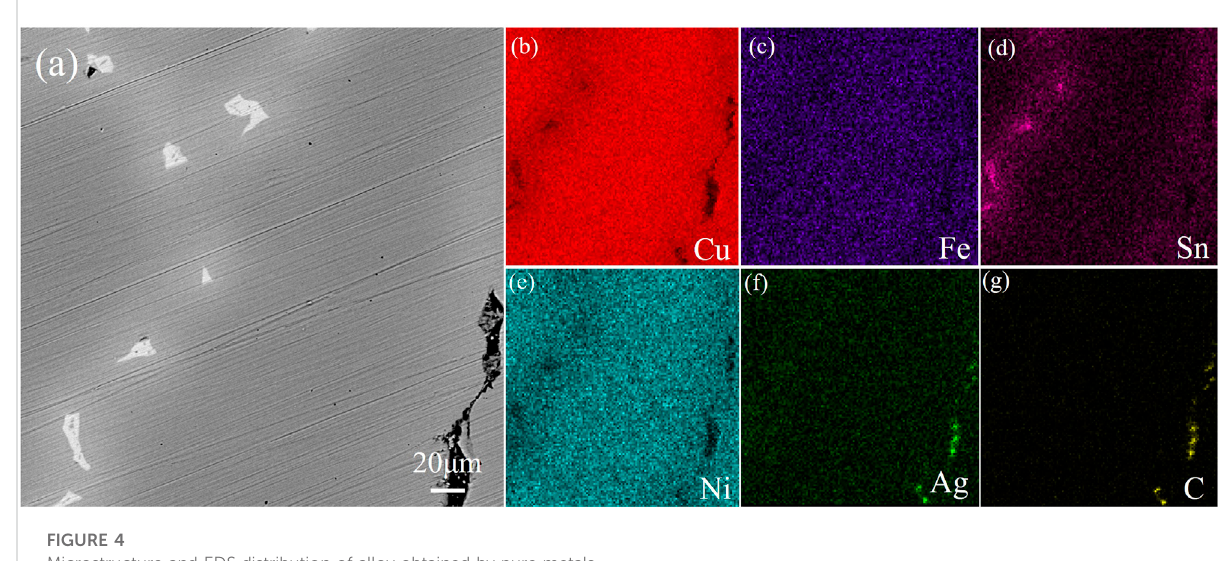
FIGURE 4 Microstructure and EDS distribution of alloy obtained by pure metals.